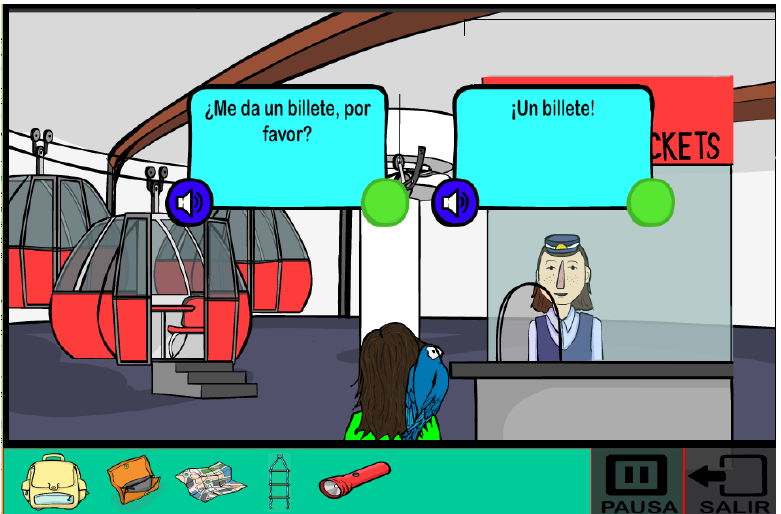
Figure 2. Example of a type of perception activity in the video game: the player must choose which of the two productions (Could I have a ticket, please? or A ticket!) is pragmatically adequate according to the communicative